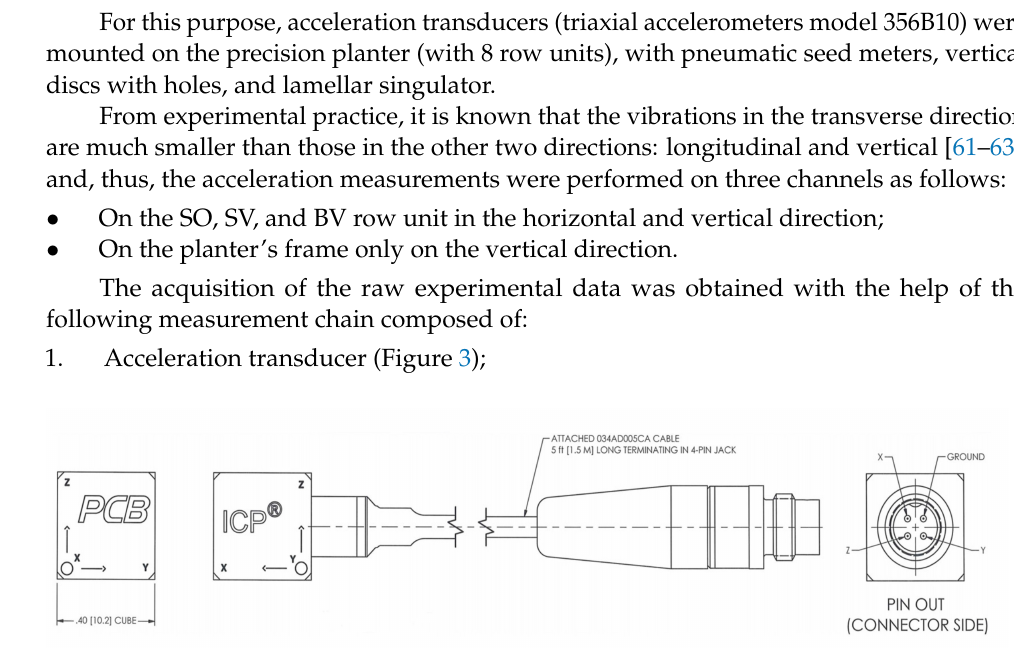
Figure 3. Scheme of PCB triaxial accelerometer model 356B10